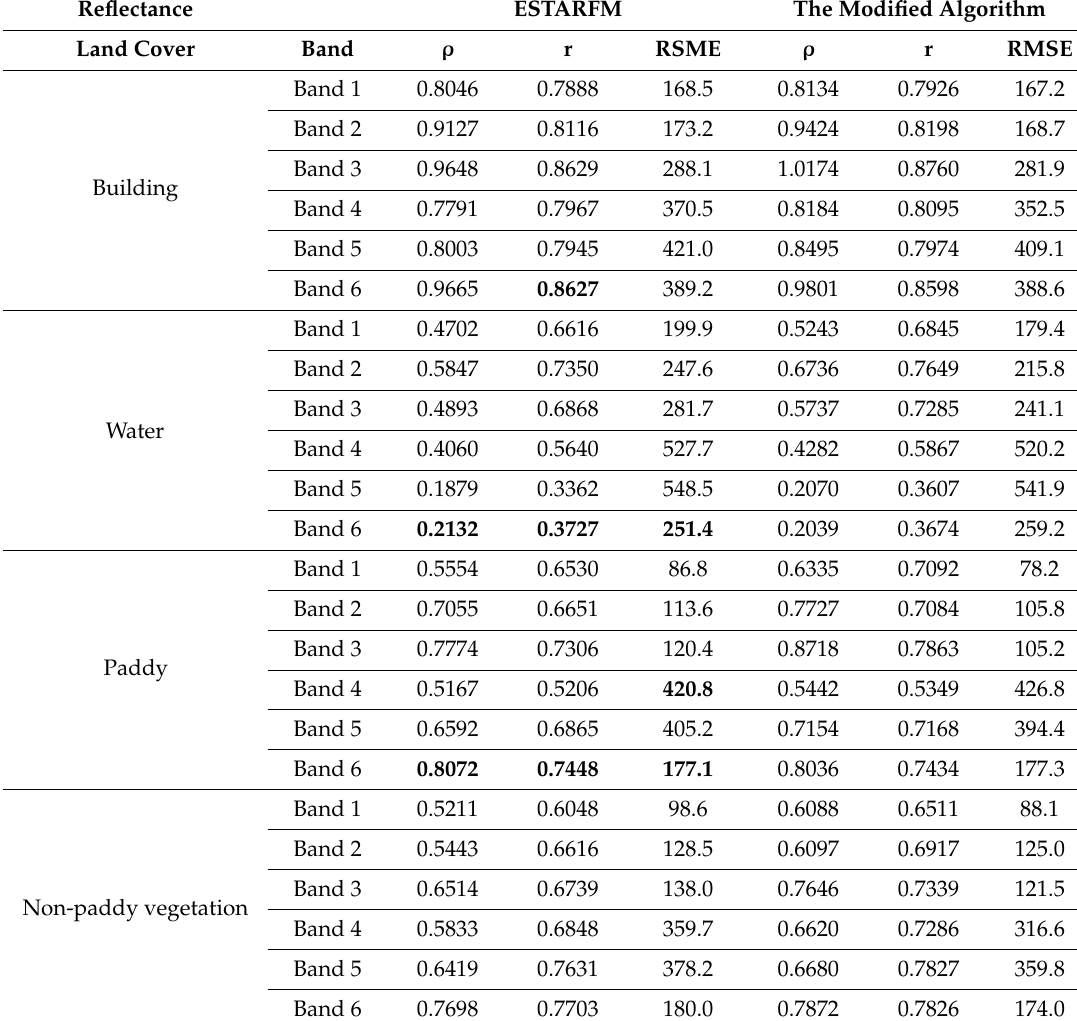
Table 3. Quantitative comparison of the prediction accuracy of ESTARFM and the modified algorithm. Reflectance ESTARFM The Modified